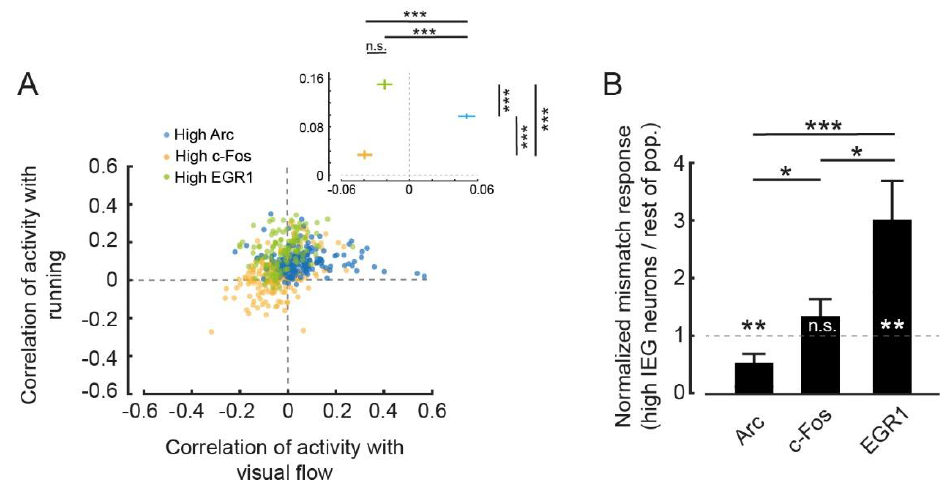
Figure 4. Functional cell type specific expression of IEGs in visual cortex. ( A ) Correlation of neuronal activity with running and of neuronal activity with visual flow during open- loop phases of conditions 2 and 3 for the top 10 % IEG expressing neurons (Arc: 197 neurons, c-Fos: 189 neurons, EGR1: 121 neurons). Inset: Average correlation coefficient for the three groups of high IEG expressing neurons. High Arc expressing neurons had the highest correlation with visual flow (Arc vs. c- Fos: p < 10 -10 , Arc vs. EGR1: p < 10 -9 , c-Fos vs. EGR1: p = 0.0791, t-test), while high EGR1 expressing neurons had the highest correlation with running (Arc vs. c-Fos: p < 10 -10 , Arc vs. EGR1: p < 10 -8 , c-Fos vs. EGR1: p < 10 -10 , t-test). ( B ) Mismatch responses in condition 3 were significantly higher for the top 10 % EGR1 expressing neurons and significantly lower for the top 10 % Arc expressing neurons than the rest of the respective population (Arc: 197 neurons, c-Fos: 189 neurons, EGR1: 121 neurons). Arc: p = 0.0461, c-Fos: p = 0.2273, EGR1: p = 0.0234; Arc vs. c-Fos: p = 0.0101, c-Fos vs. EGR1: p = 0.048, Arc vs. EGR1: p = 0.0057,